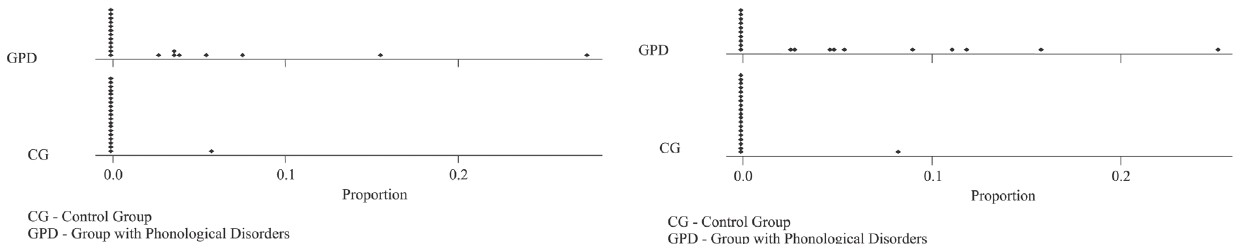
Figure 4 - Points of proportion of distortion occurrences in the SS2 test.